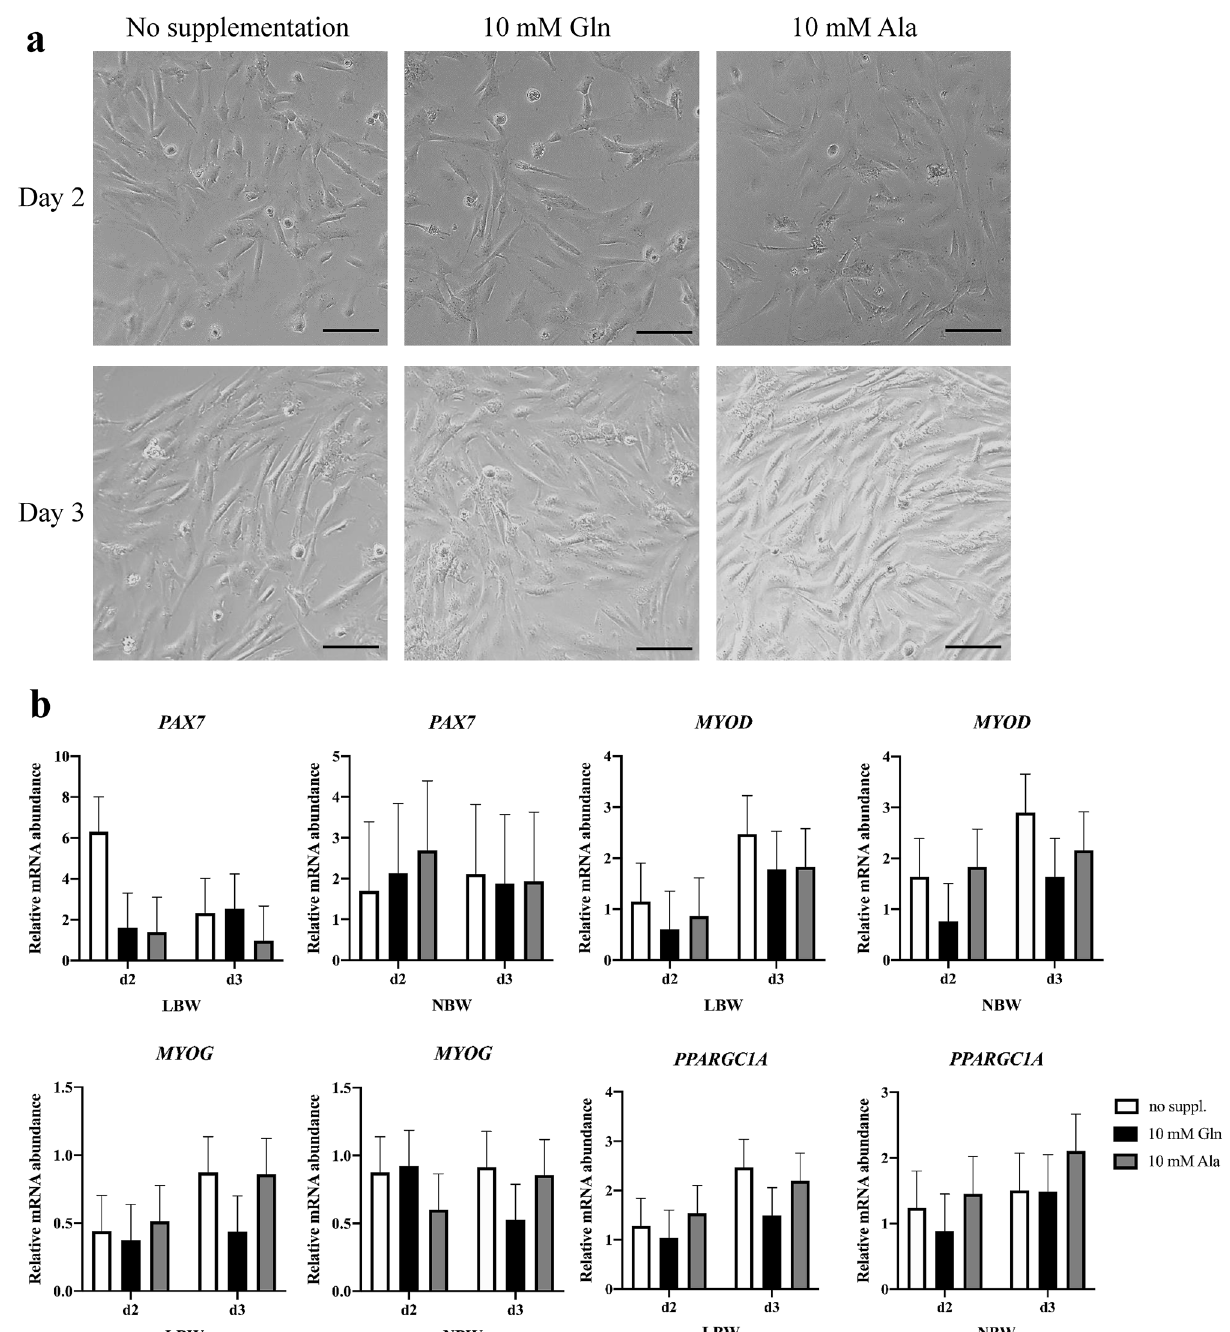
Figure 5. Expression of muscle growth-related genes in proliferating porcine myogenic cells. ( a ) Representative microscopic images of cells of the same sample at day 2 and day 3 without supplementation or with 10 mM Gln or Ala. Scale bars represent 200 µm. ( b ) Relative mRNA abundances of PAX7 , MYOD , MYOG and PPARGC1A in proliferating cells of low (LBW) or normal birth weight (NBW) piglets at day 2 and day 3 after seeding. Values were normalized to YHWAZ and PPIA expression and are presented as LSmeans and SE (n = 3 per nuclei number decreased with age, whereas the muscle fiber size increased 16 . In the current study, we observed a stronger reduction of the number of proliferating cells in older piglets as indicated by much less BrdU-positive nuclei. Accordingly, studies of Cardasis and Cooper 37 and Mesires et al. 24 reported that the number of satellite cell nuclei is reduced with age in relation to the total nuclei number. Thus, stimulation of satellite cell proliferation could be more effective in younger animals. However, skeletal muscle cells represent a heterogeneous population of cells within muscle tissue, beside muscle fibers and satellite cells there are fibroblasts, preadipocytes, adipo- cytes, endothelial and immune cells, etc. Fully differentiated cells, such as adipocytes and muscle fibers, are no